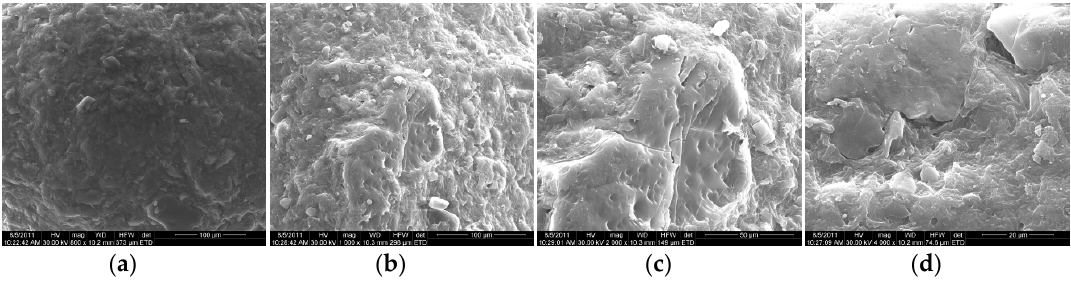
Figure 2. Scanning electron microscopy (SEM) images of the surface of inert pellet samples ( a ) 800× magnification; ( b ) 1000× magnification; ( c ) 2000× magnification; ( d ) 4000× magnification.